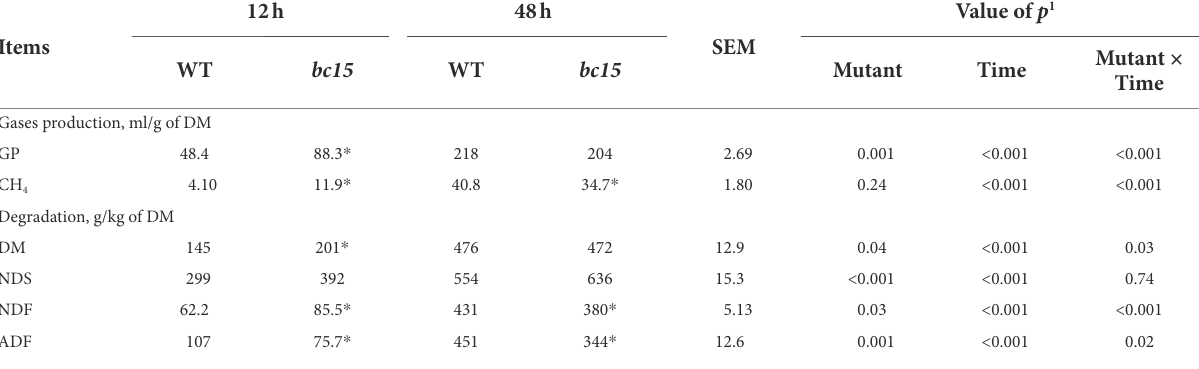
TABLE 4 Gases production and degradation of wild-type (WT) and brittle culm 15 ( bc15 ) mutant rice straws after 12- and 48-h in vitro ruminal incubation ( n = 3).